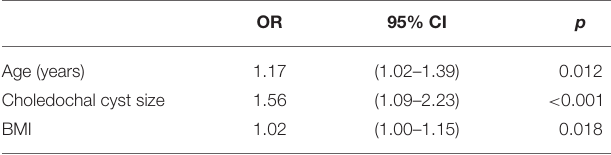
TABLE 1 | The factors associated with operating time. TABLE 2 | Multivariate analysis of related factors for longer operating time.